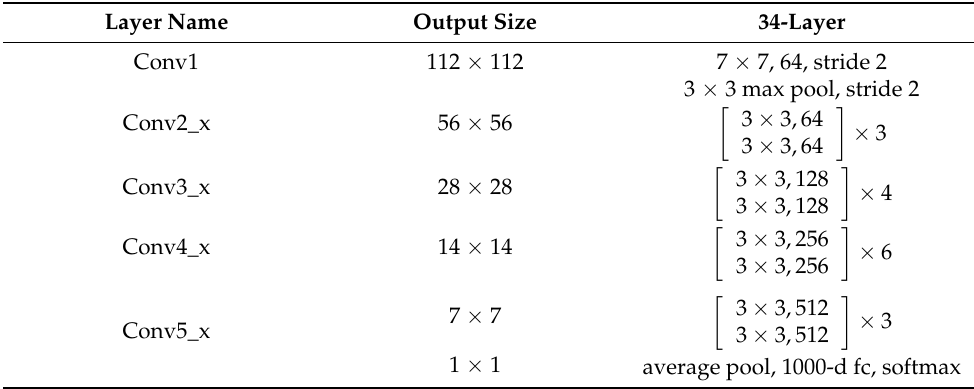
Table 2. The structure of